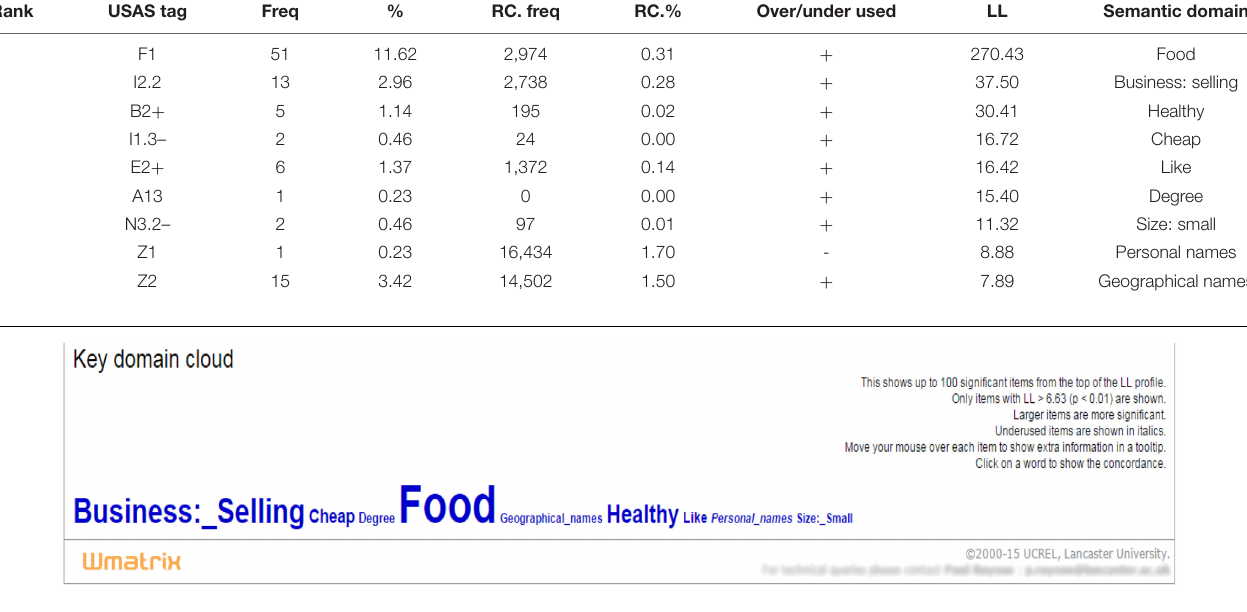
TABLE 2 | Key semantic domains of Fast Food Invasion .